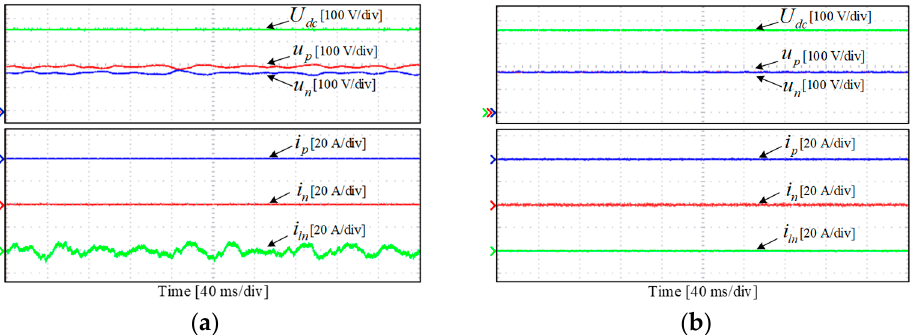
Figure 10. Experimental results of different DPC strategies under a no load condition. ( a ) Classic DPC strategy and ( b ) proposed DPC strategy.